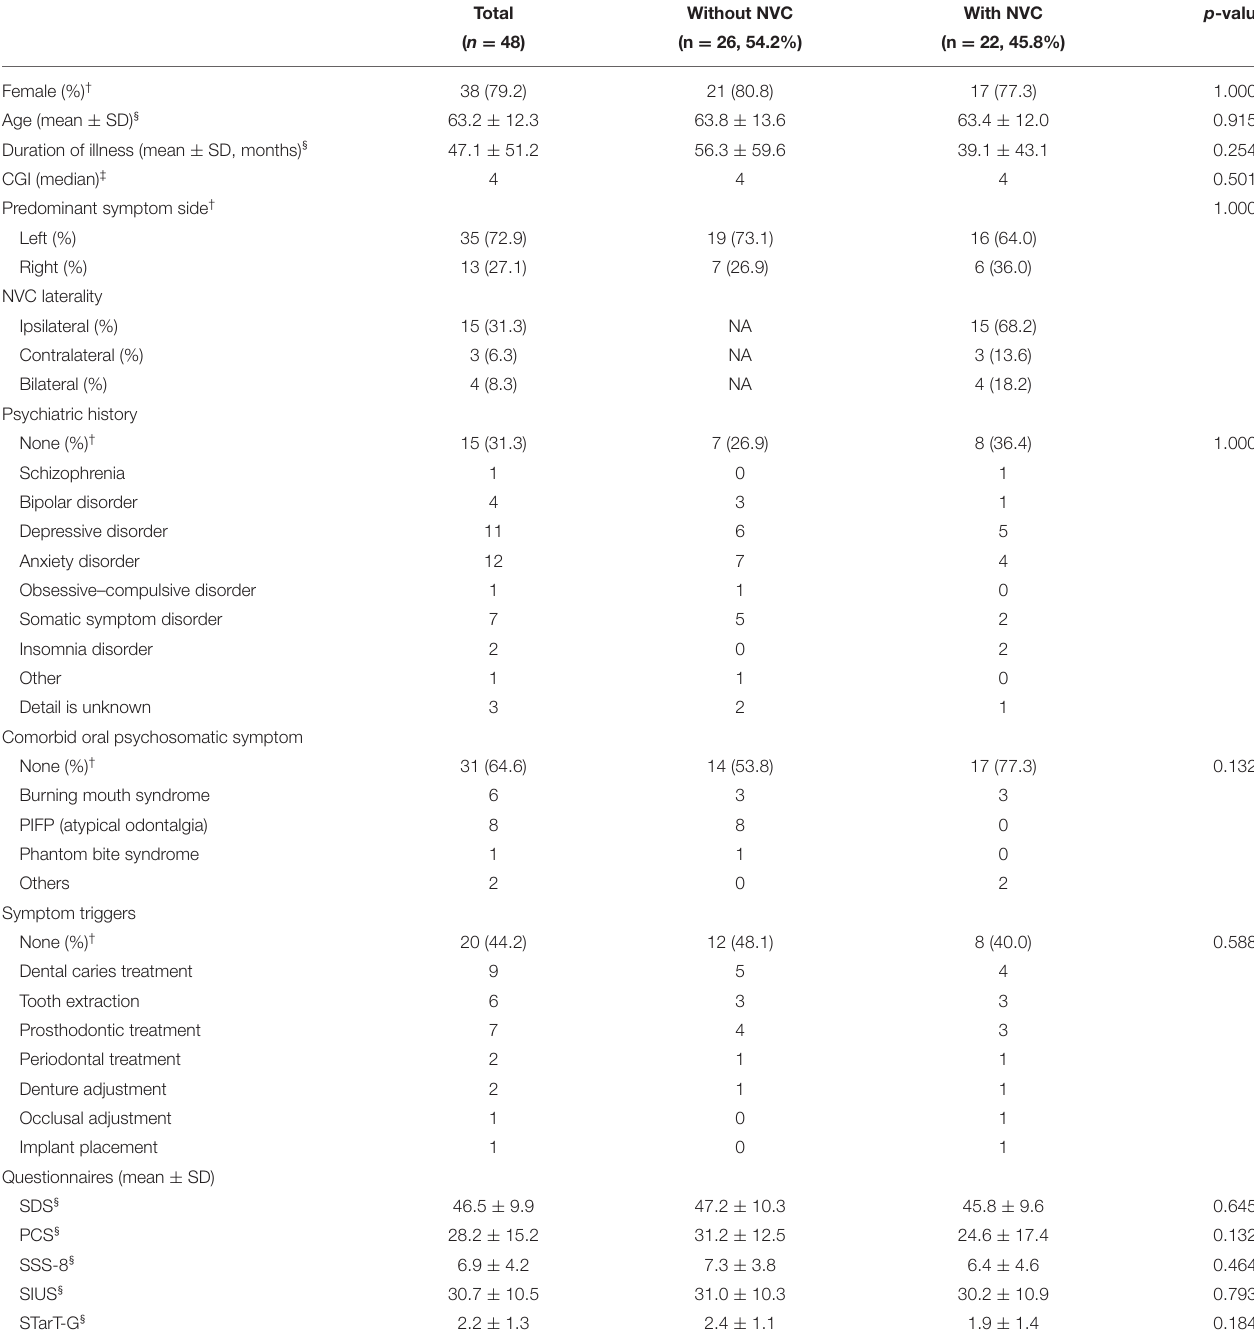
TABLE 1 | Demographic and clinical characteristics of the patients having predominantly unilateral oral